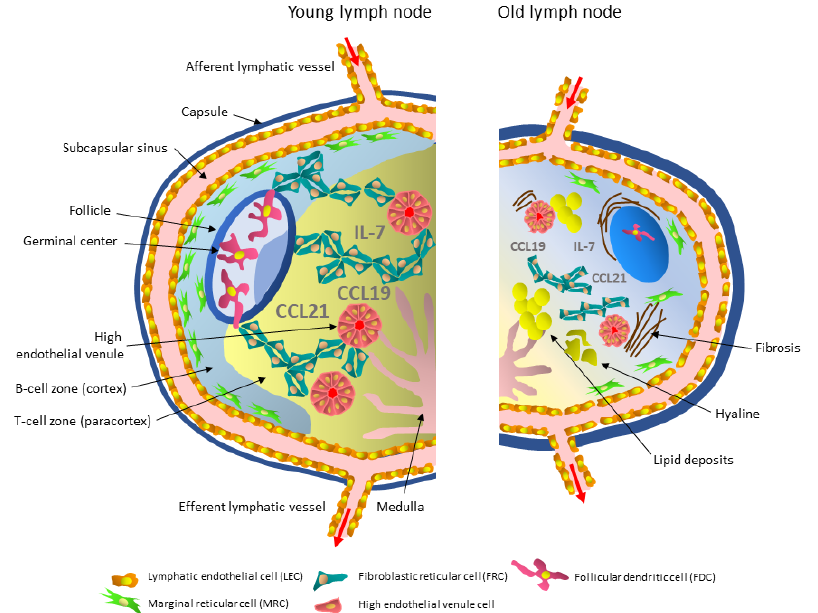
Figure 1. Simplified diagram of aging-associated lymph node stromal microenvironment changes. Compared to the young lymph node, the aged node is smaller, has a thick capsule, contains lipid and hyaline deposits, and is fibrotic. Functional zones become difficult to distinguish. Lymphatic vessels become permeable due to a loss of glycocalyx and GAP proteins. There are fewer HEVs, and high endothelial venule cells lining them are less rectangular and more compressed. The number of fibroblastic reticular cells (FRCs) is reduced, cells are more compacted, rigid, and form less “spongy” structures. Follicles are smaller with reduced or absent germinal centers and indistinguishable light and dark zones. The number of follicular dendritic cells (FDCs) is decreased, and the remaining cells are smaller. The number of marginal reticular cells (MRCs) is also reduced. The amount of homeostatic chemokines CCL19, CCL21, and IL-7 is